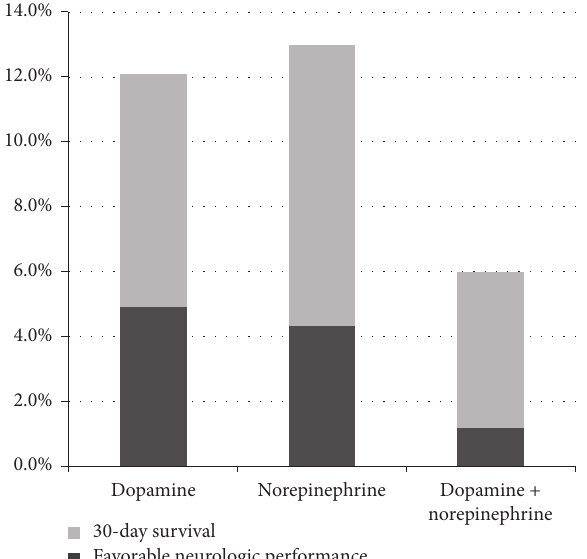
Figure 3: Thirty-day survival and favorable neurologic performance rates in the three study groups. Thirty-day survival rates:12.1%, 13.0%, and 6.0% ( p � 0 . 022); favorable neurologic performances: 4.9%, 4.3%, and 1.2% ( p � 0 . Table 2: Association of postresuscitation inotropic agent therapy and 30-day survival and favorable neurologic performance. 30-day survival